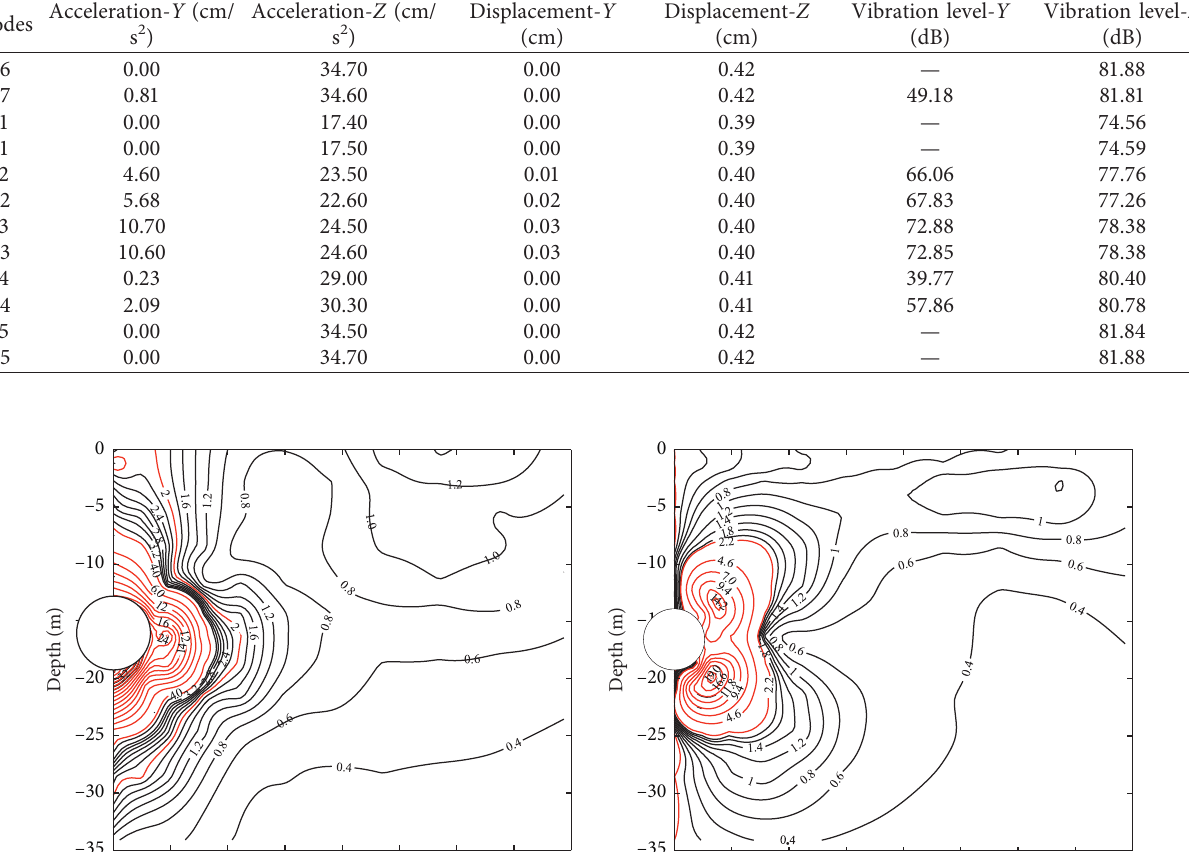
Table 10: Response results at nodes in the tunnel.